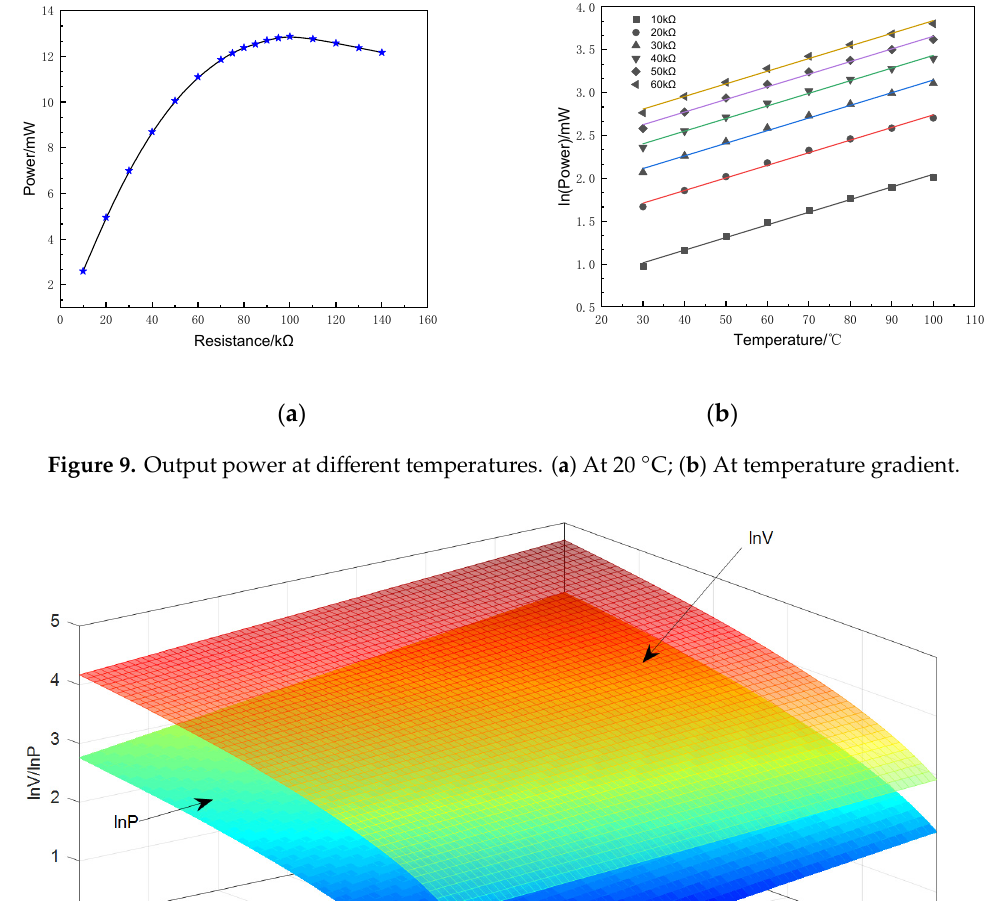
Figure 10. Comparison of the output voltage and the output power.